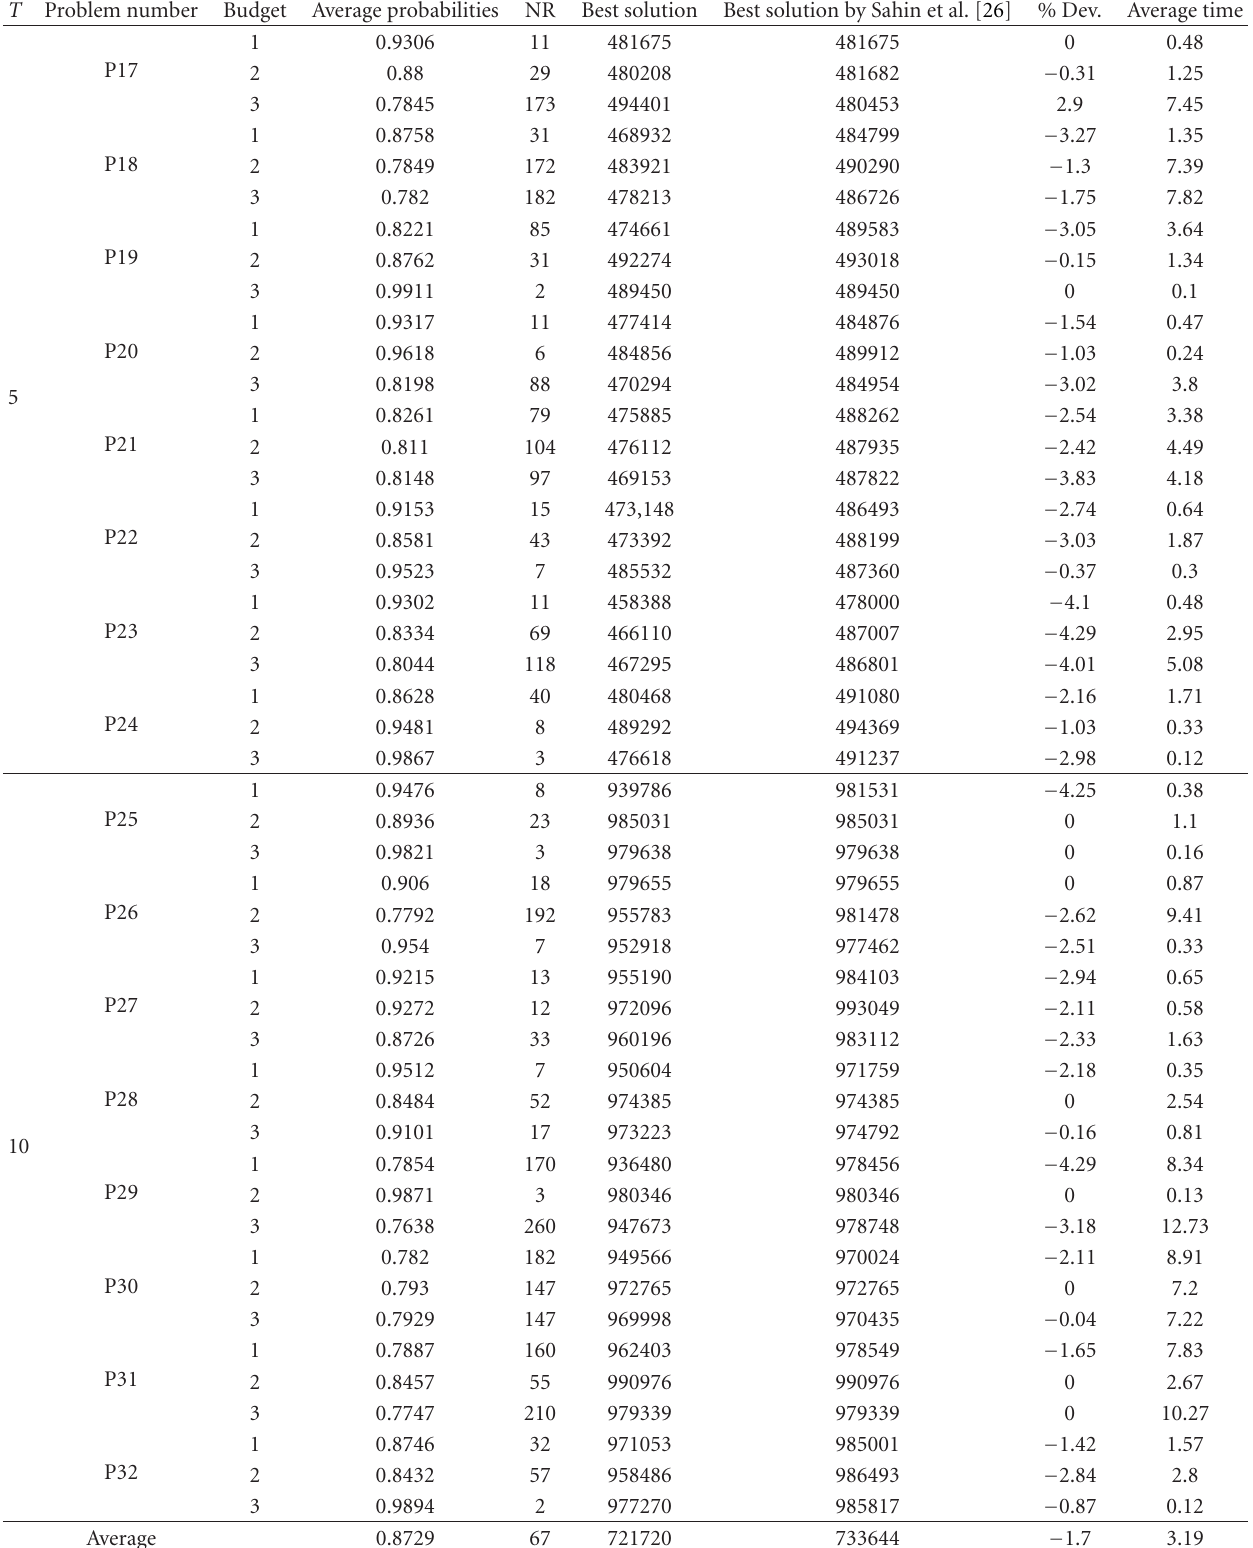
Table 2: The computational results with significant level 99% with N =